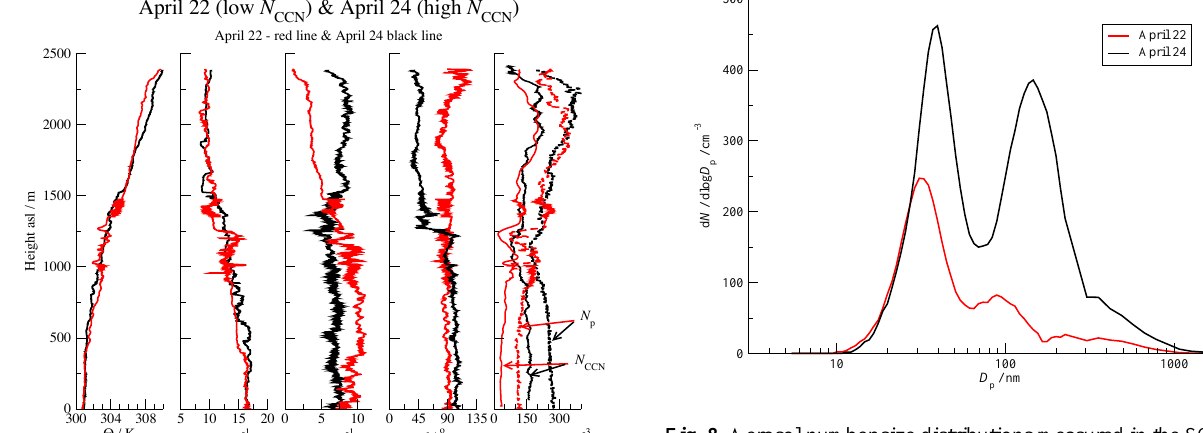
Fig. 8. Aerosol number size distributions measured in the SCL (be- low 400m) on 22 and 24